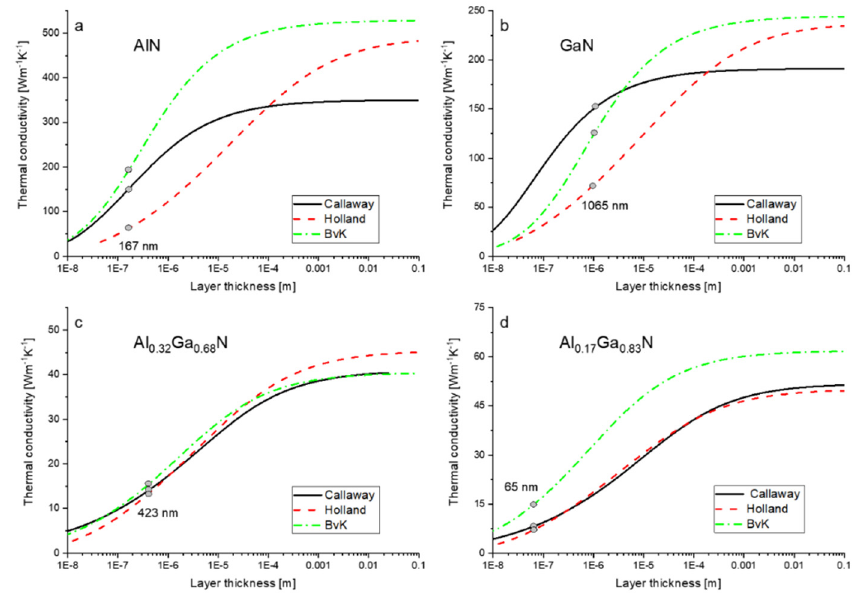
Figure 6. Thickness dependent thermal conductivity as calculated using the Hua–Minnich suppression function approach for ( a ) AlN, ( b ) Al 0.32 Ga 0.68 N, ( c ) GaN, and ( d ) Al 0.17 Ga 0.83 N. Calculations were performed at 300 K determined by using Equation (8) with the relaxation times determined by the Callaway, Holland and BvK models.